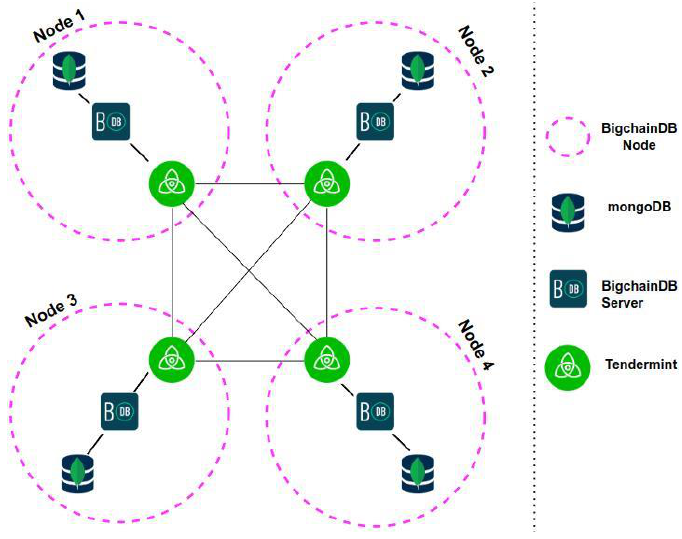
Figure 5. The four main components of the BigchainDB network. Our scenario implementation is based on using BigchainDB as a database that is characterized by blockchain features. It has high throughput, low latency, and high per- formance; it is decentralized by design and has built-in asset support. We have used BigchainDB version 2.2.2 using pip3 and docker for installation. BigchainDB server, whose main running process is seen in (Figure 6) has to be installed from the GitHub repos- itory Python library and packages and execute docker functions or directly by using Python